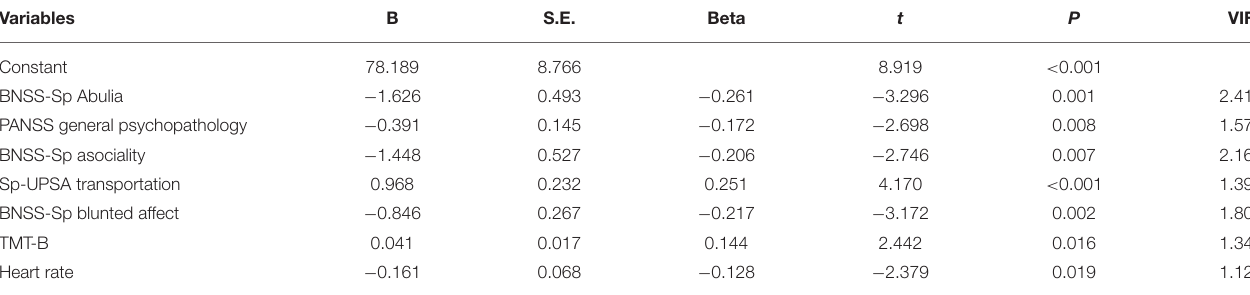
TABLE 5 | Multiple linear regression model predicting real-world functioning (PSP total